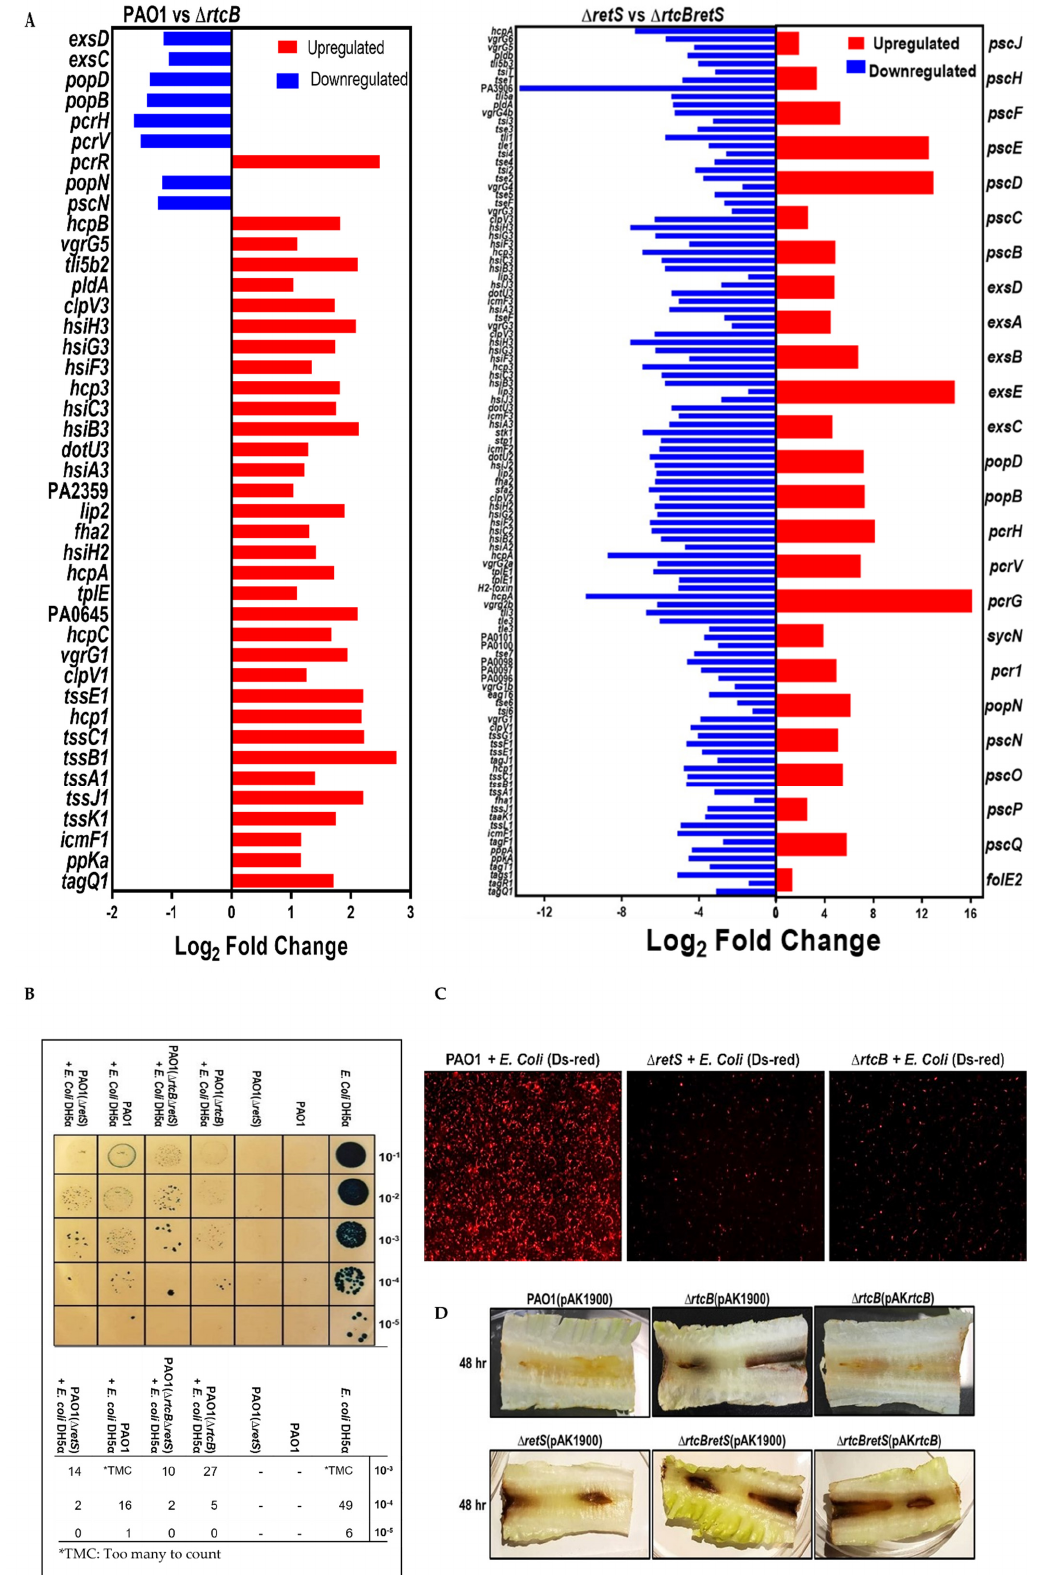
Figure 5. Functional T6SS in ∆ rtcB participated in the killing of E. coli and infection of lettuce leaves. ( A ) Differential ex- pression of T3SS and T6SS genes in PAO1 vs. PAO1( ∆ rtcB ) and PAO1( ∆ retS ) vs. PAO1( ∆ rtcB ∆ retS ). ( B ) Competitive pro- karyotic killing assay, in which co-cultures of E. coli with predator Pseudomonas strains were spotted on coliform agar plates. The blue color represents live E. coli cells. The table shows the colony forming unit (CFU) at 10 − 5 , 10 − 4 , and 10 − 3 dilutions. Lower CFU of live E. coli cells (blue colonies) in co-cultures of PAO1( ∆ rtcB )+ E. coli , in comparison with co- cultures of PAO1+ E. coli strains, represent the higher killing potential of PAO1( ∆ rtcB ) with activated T6SSs. ( C ) Fluores- cence competition assay showing live E. coli harboring pilG -DsRed fluorescent reporter in red. ( D ) Photographed lettuce midribs show the infection sites after 48 h. PAO1( ∆ rtcB ) and PAO1( ∆ rtcB ∆ retS ) caused a more robust infection than PAO1 and PAO1( ∆ retS ), respectively.